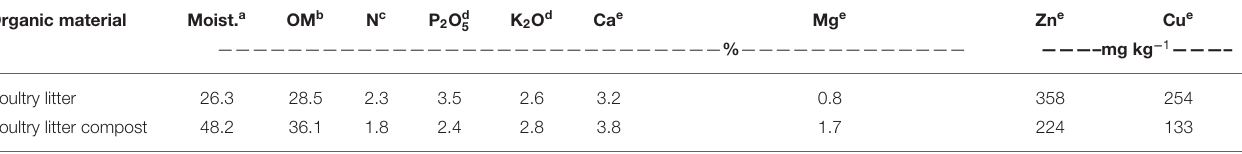
Poultry litter Poultry litter compost